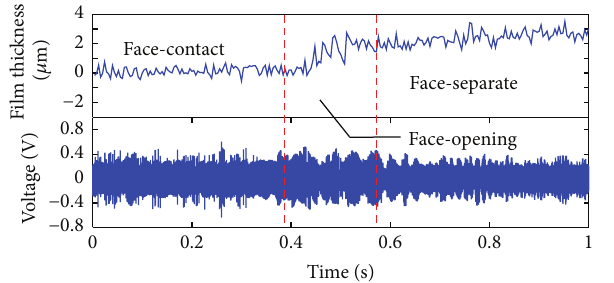
Figure 3: The signals during the seal startup.